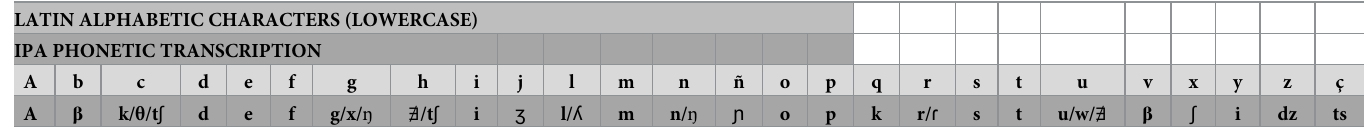
Table 5. Spanish language. Latin alphabet (lowercase letters) and phonetic transcription (IPA symbols).